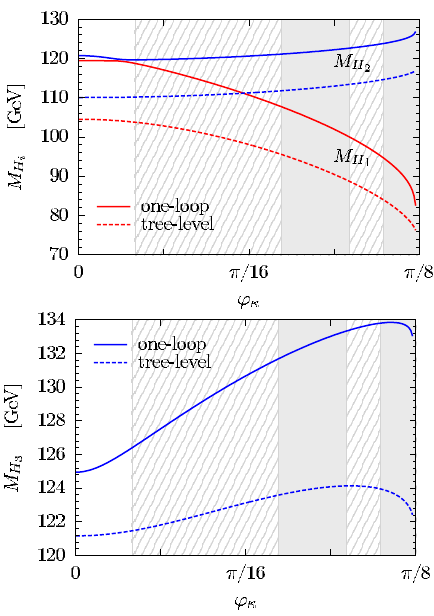
Figure 1. Upper panel: tree–level (dashed) and one–loop masses (full) for H 1 and H 2 states for a C –NMSSM scenario. Lower panel: same for the H 3 state. The exclusion region due to LEP, Tevatron and 7 TeV LHC data is shown as a grey area, the region with the SM-like Higgs boson not being compatible with an ex- cess of data around 125 GeV as dashed area. The figures have been taken from Ref. [7].